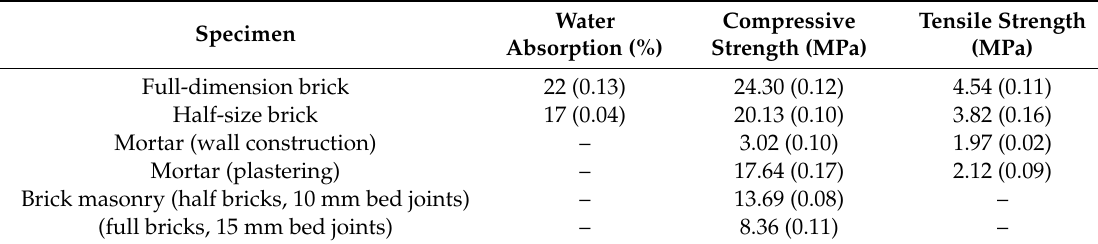
Figure 7. Solid fired clay bricks used for the construction: ( a ) full-dimension and ( b ) half-size. Table 4. Results of the material characterization